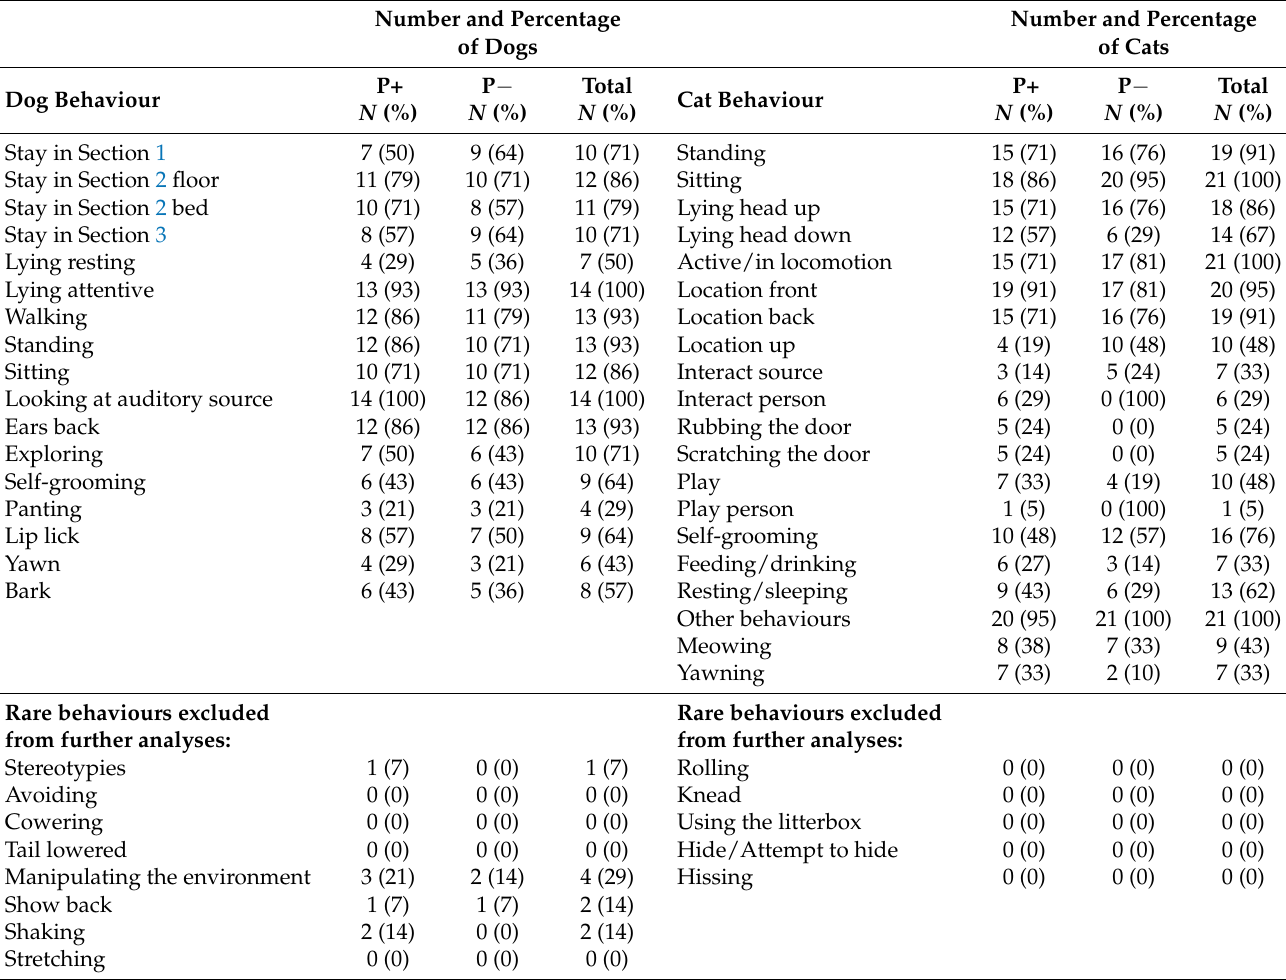
Table 3. Number and percentage of dogs ( N = 14) and cats ( N = 21) showing a specific behaviour during the two testing conditions (P+: person present or P − : person not present during the play back of the audio